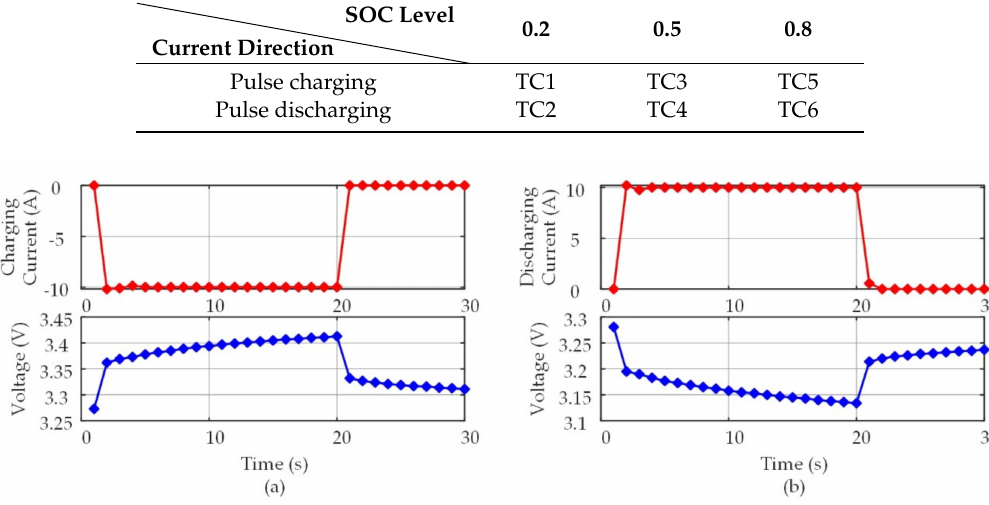
Figure 4. Pulse current and voltage response in the current pulse test. ( a ) Charging; ( b )